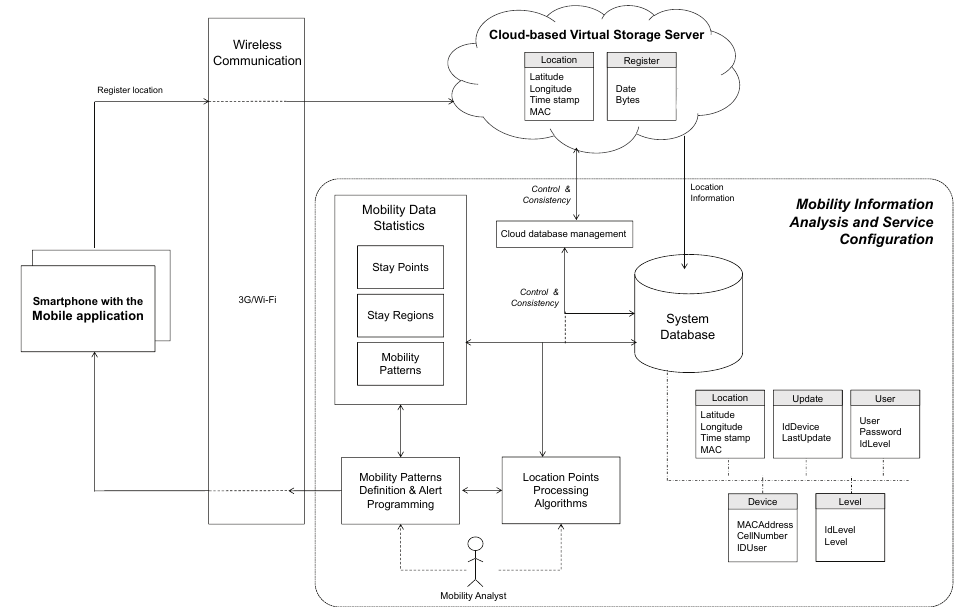
Figure 3. Location-based mobility service